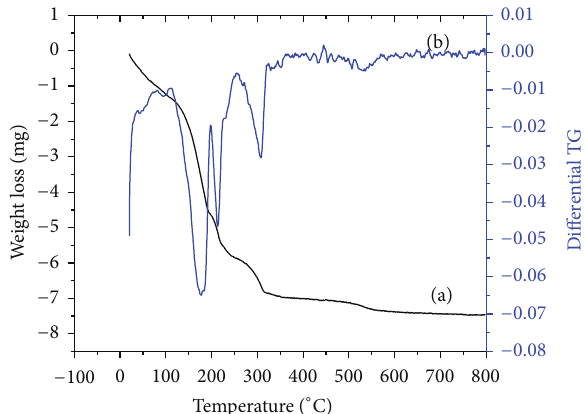
Figure 16: (a) TGA thermograms of KPDMUG. (b) Differential plot of KPDMUG.